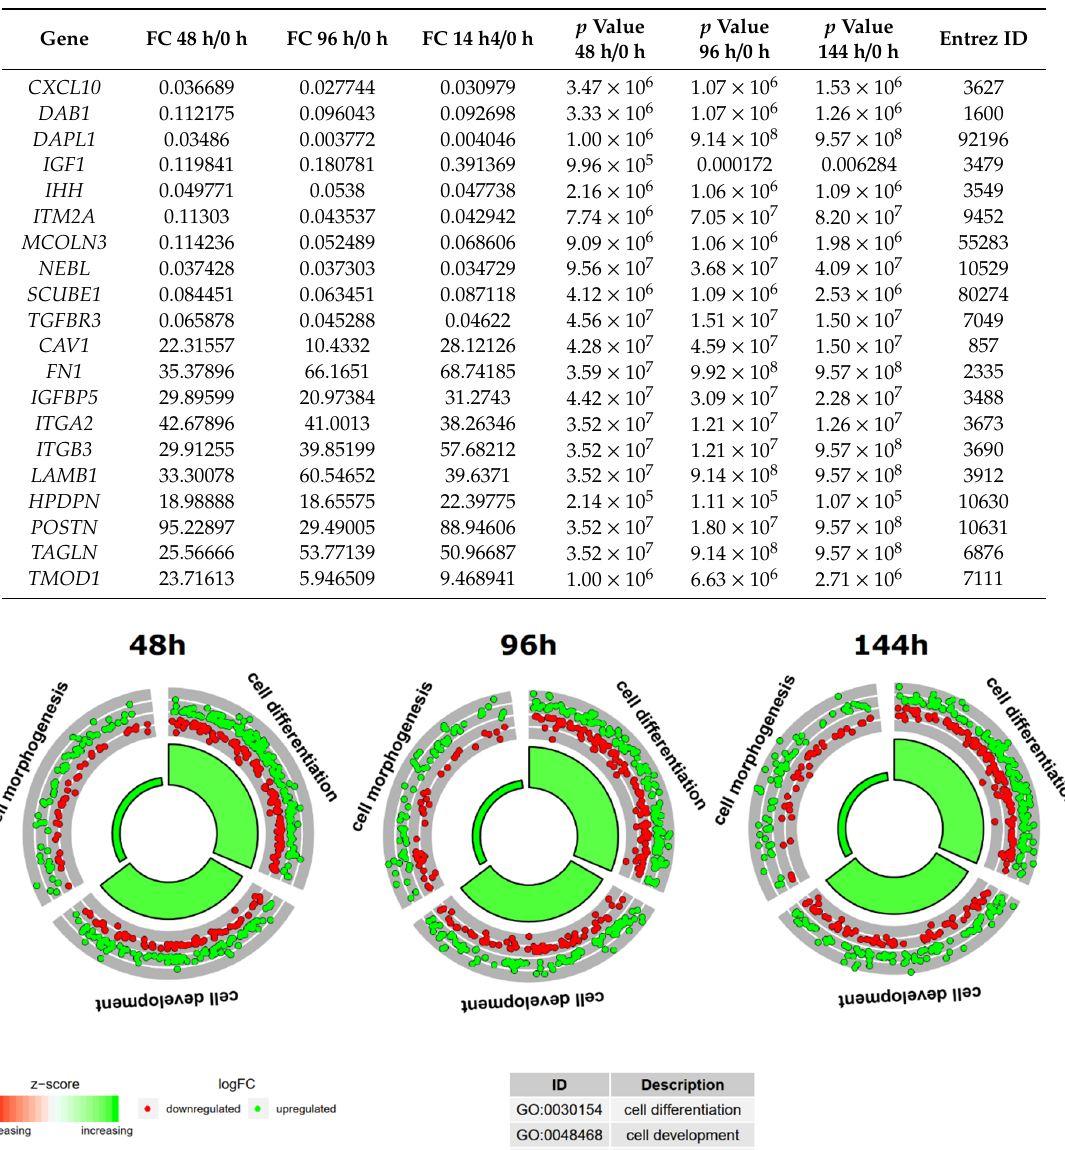
Table 1. Fold changes, adjusted p values and ENTREZ gene ID of the 20 chosen di ff erentially expressed genes belonging to the “cell morphogenesis”, “cell development” and “cell di ff erentiation gene ontology (GO) terms.